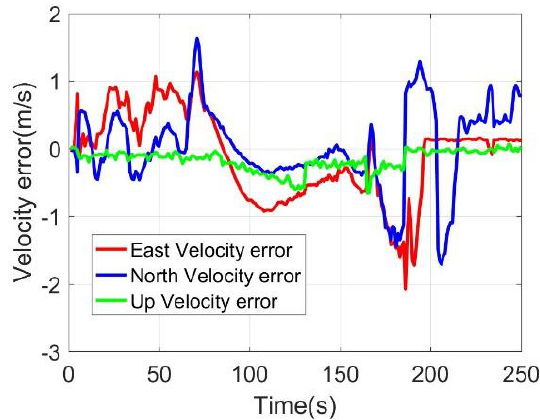
Figure 18. Velocity errors.